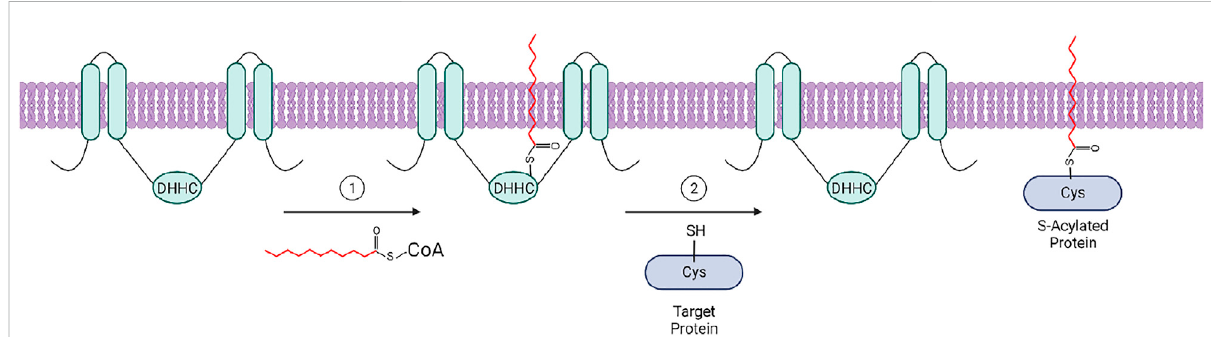
FIGURE 2 The two-step “ ping pong ” mechanism of zDHHC-mediated protein S-acylation: 1) The acyl group from an acyl-CoA molecule is transferred to the catalytic cysteine residue of the ZDHHC enzyme within the cytosolic loop between transmembrane domains two and three, forming an acyl- enzyme intermediate. 2) The acyl group is subsequently transferred to a free cysteine residue of a target protein, resulting in an S-acylated protein. Created with